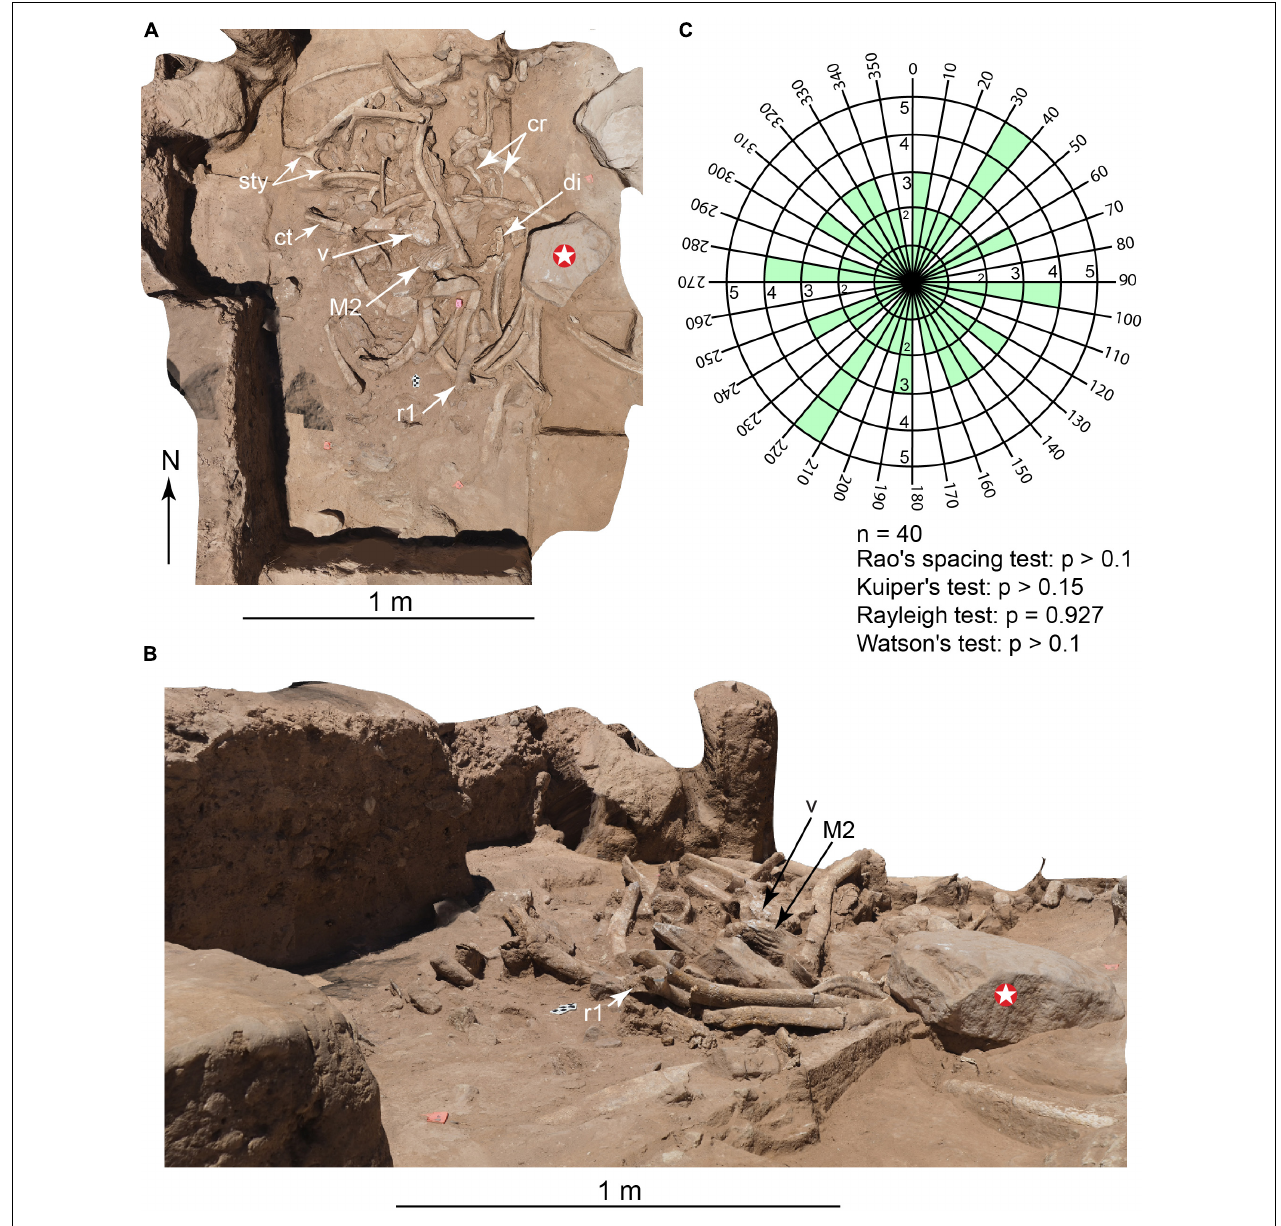
FIGURE 2 | Main bone accumulation, following removal of adult face. (Photogrammetry images). (A) Overhead view. (B) Oblique view. (C) Bi-directional rose diagram showing random orientation of 40 elongate elements exposed; see text for explanation. Cr, calf ribs; Ct, calf tibia; Di, adult cranial diplöe; M2, adult